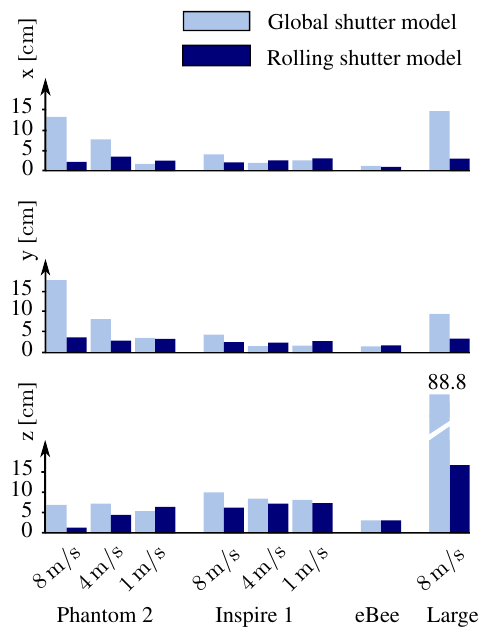
Figure 9: RMS error for Phantom, Inspire, eBee and the large dataset from Table. 3. In gray and dark-blue are the errors for the classical and rolling shutter model, respectively.